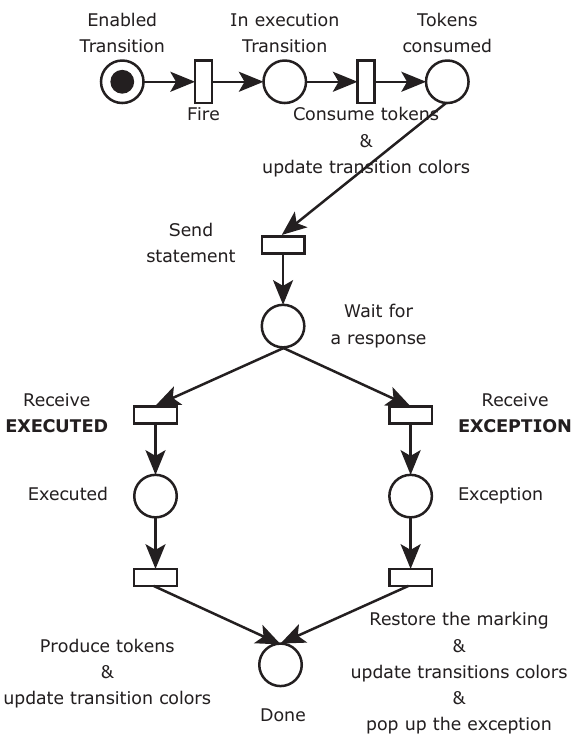
Figure 7. The protocol followed by MEE when firing a